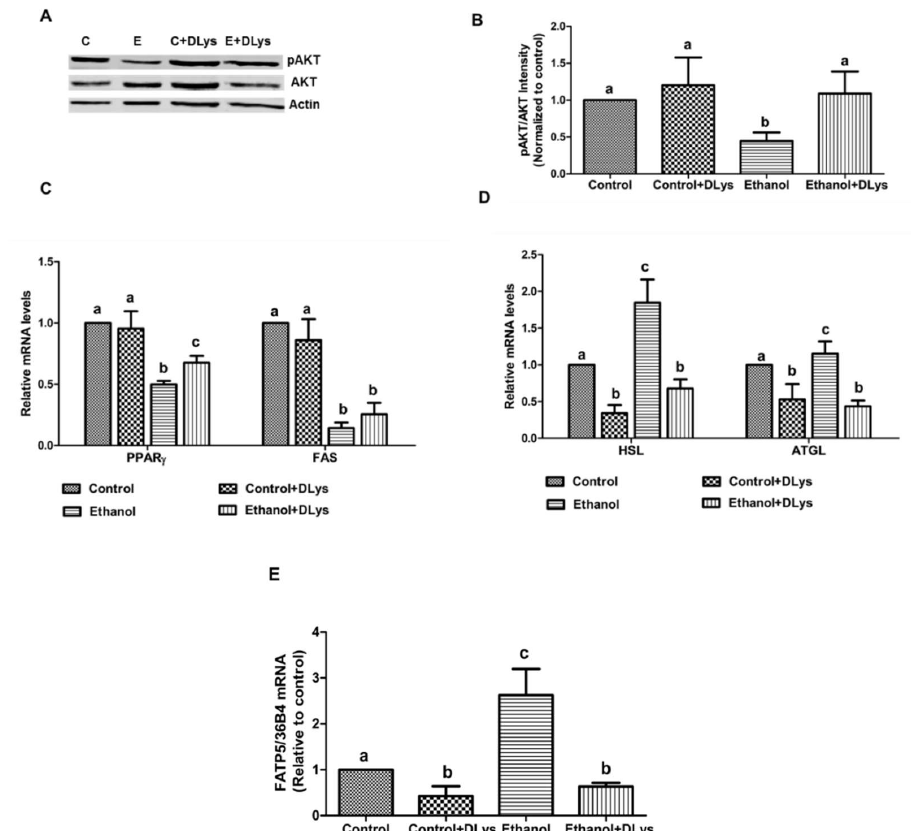
Figure 6. Quantitative analysis of the adipose fatty acid breakdown and transport. ( A ) Representative western blots from the control (C), ethanol (E), control + DLys (C + DLys), and the ethanol + DLys (E + DLys) for total and active AKT. ( B ) Densitometric ratios of active (phosphorylated) to total AKT in the liver of experimental rats. ( C ) qRT–PCR analysis of gene expression related to adipose fatty acid metabolism—peroxisome proliferator-activated receptor γ (PPARγ, a key transcription factor for adipocytes differentiation and expansion) and FAS (fatty acid synthase). ( D ) qRT–PCR analysis of gene expression related to fatty acid breakdown—hormone-sensitive lipase (HSL), adipose triglyceride lipase (ATGL). ( E ) Fatty acid transporter protein 5 (FATP5) to ribosomal protein expression ratio in the adipose tissue of experimental rats. Values are expressed as a relative to the control values. Values are means ± SEM, n = 8. Values not sharing a common letter are statistically different, p ≤ 0.05.